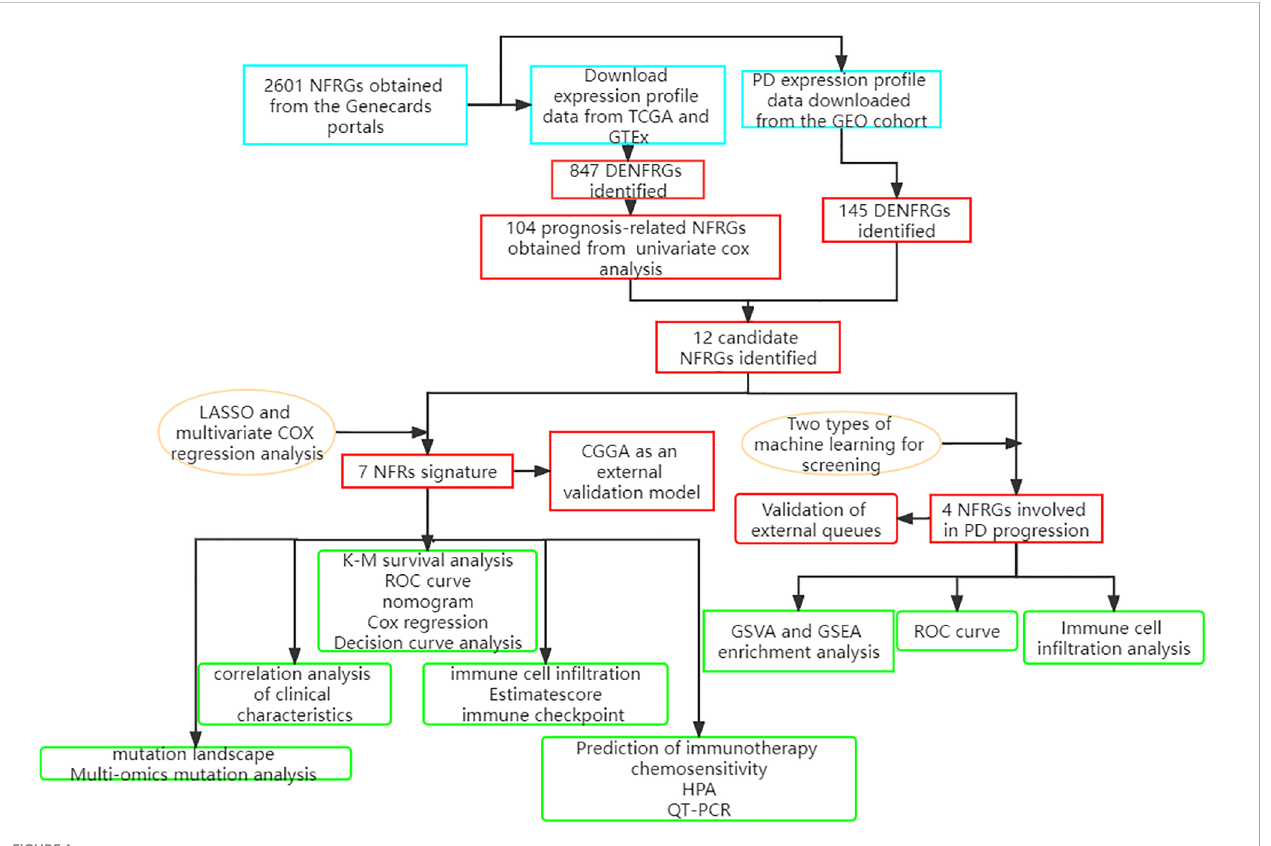
FIGURE 1 A detailed fl ow chart showing the NFRGs in GBM and